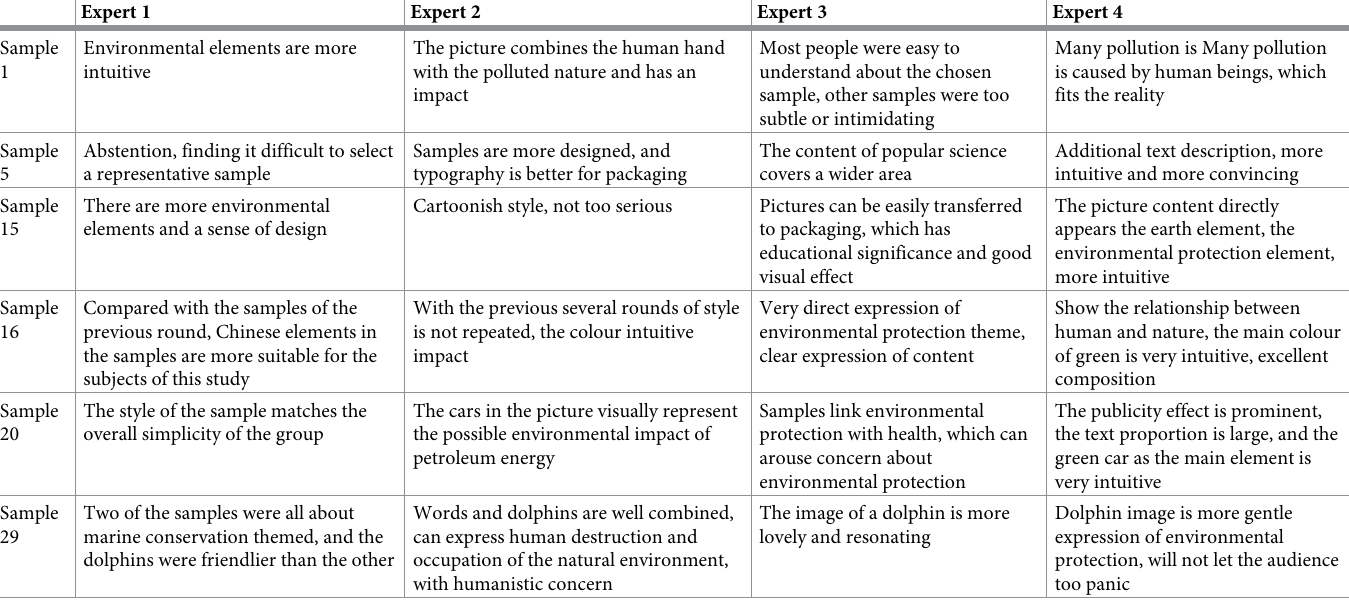
Table 6. Experts’ reasons for selecting representative samples.